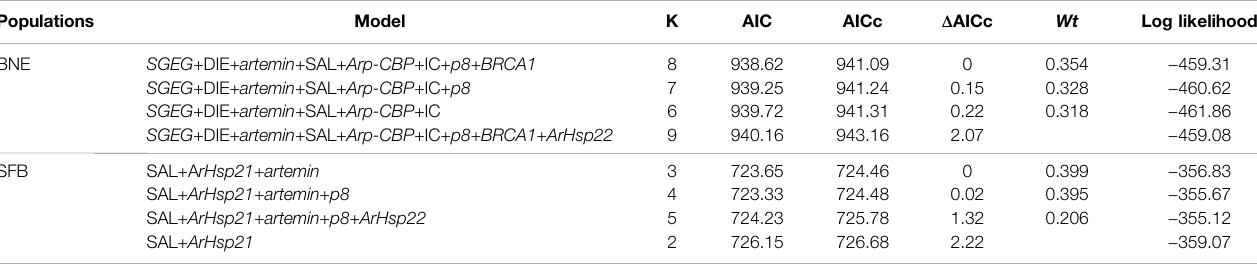
TABLE 8 | Multivariate model selection results in Barro Negro (BNE) and San Francisco Bay (SFB) populations.